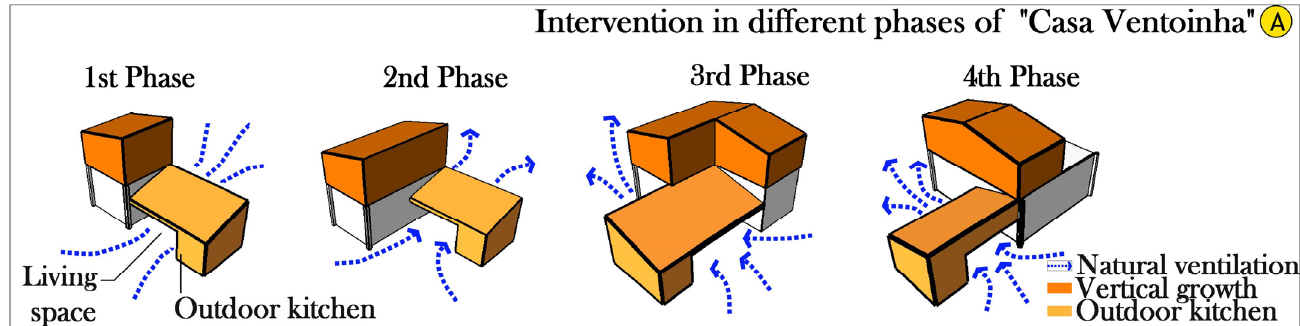
Figure 16. Interventions in the model house.